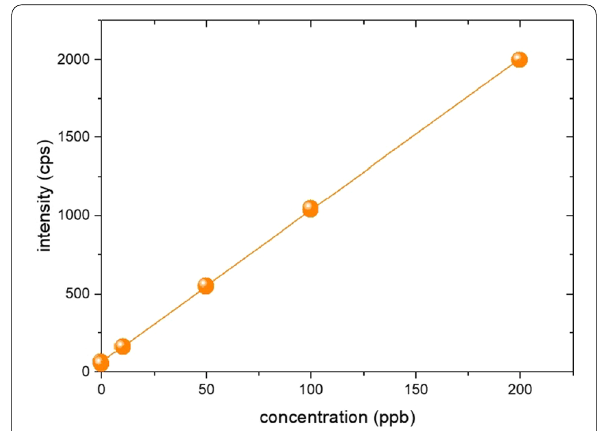
Fig. 1 Calibration curve by ICP-OES